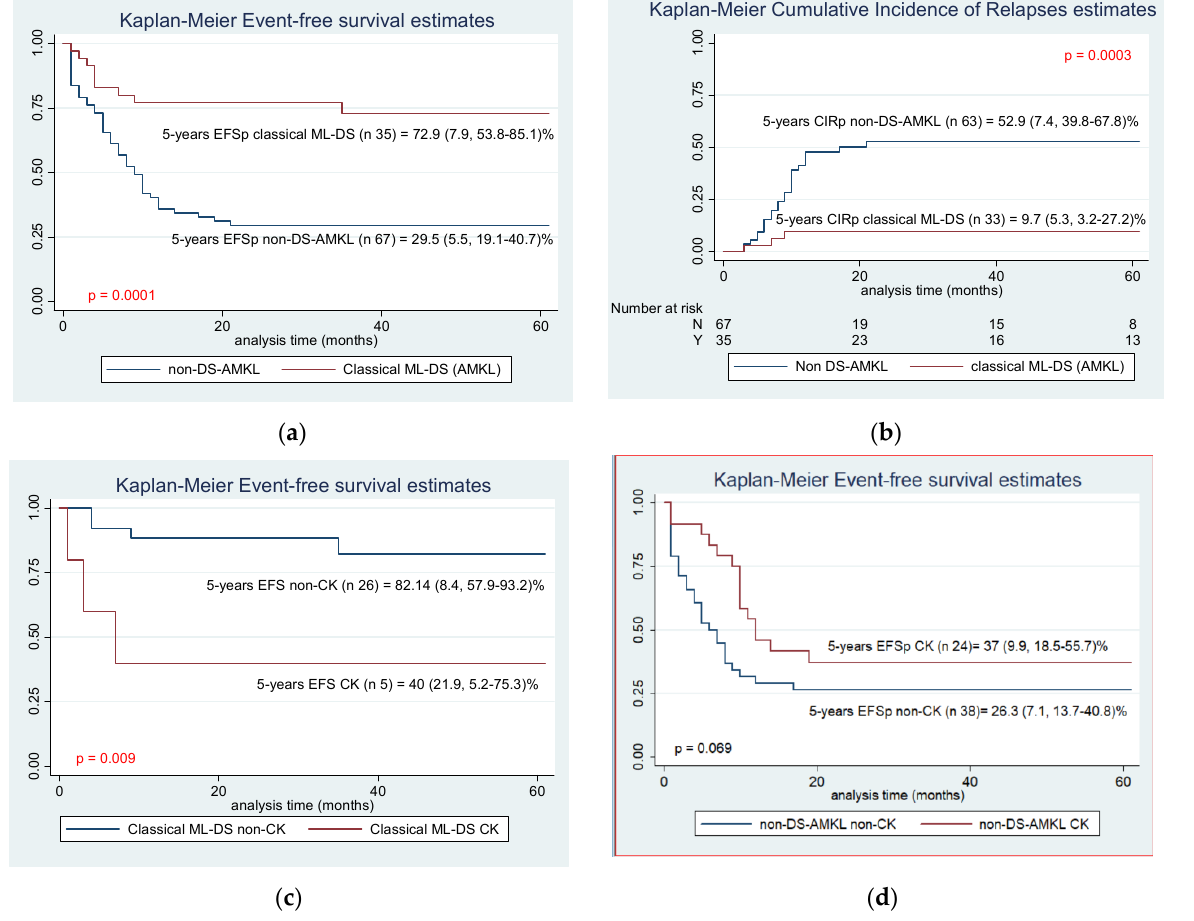
Figure 3. 5-years EFSp and CIRp for total classical ML-DS (AMKL) and non-DS-AMKL population and complex karyotype. ( a ) 5-years EFSp for classical ML-DS (AMKL) and non-DS-AMKL population, ( b ) 5-years CIRp for classical ML-DS (AMKL) and non-DS-AMKL population, ( c ) classical ML-DS (AMKL) EFSp at 5-year according to complex karyotype, ( d ) non-DS-AMKL EFSp at 5-year according to complex karyotype.